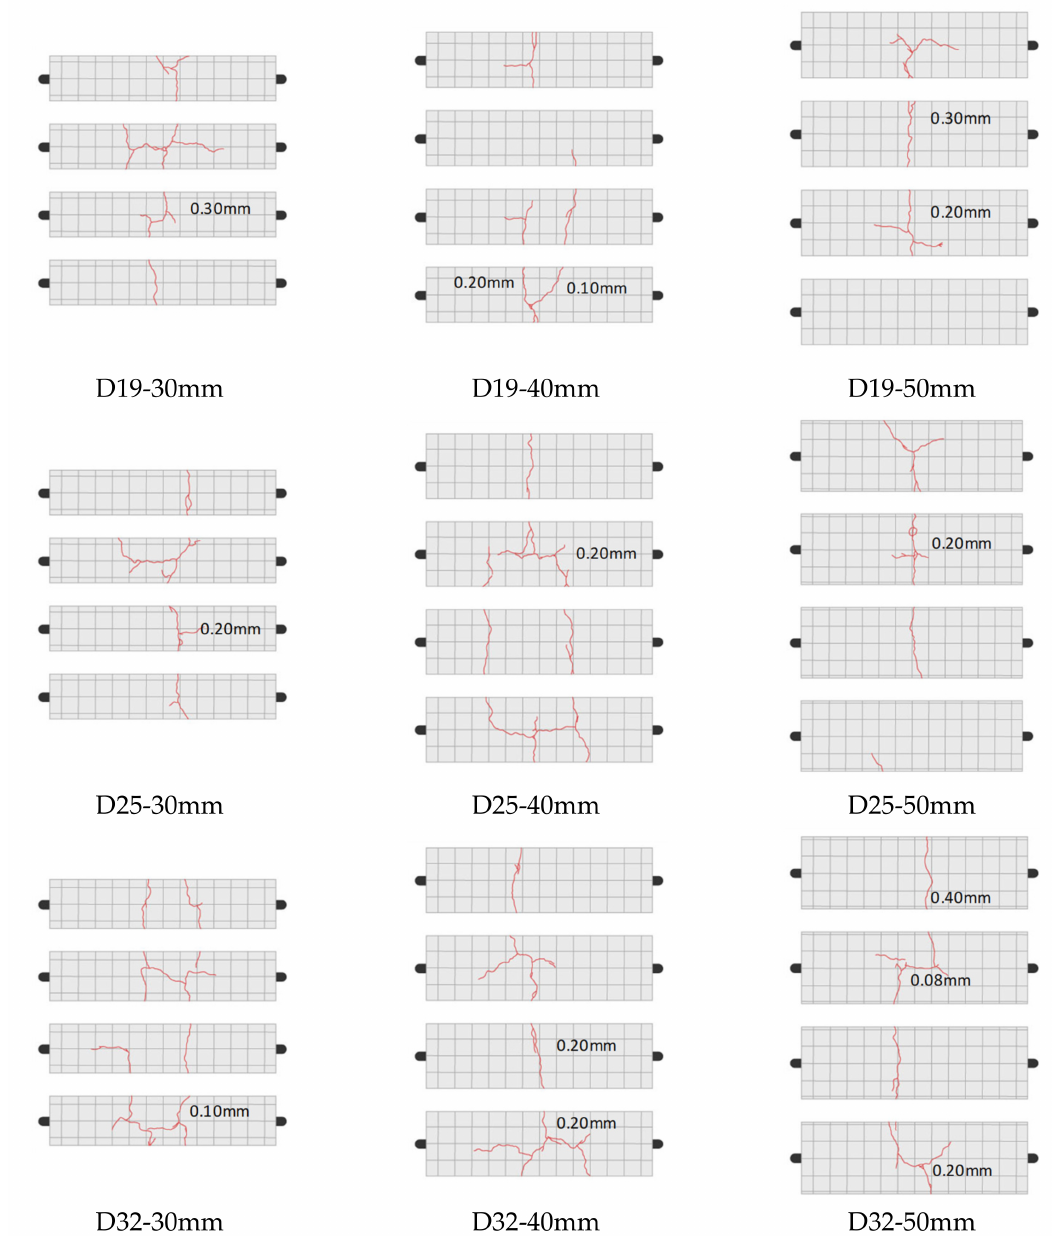
Figure 7. Crack characteristics of single reinforced concrete by induction heating.